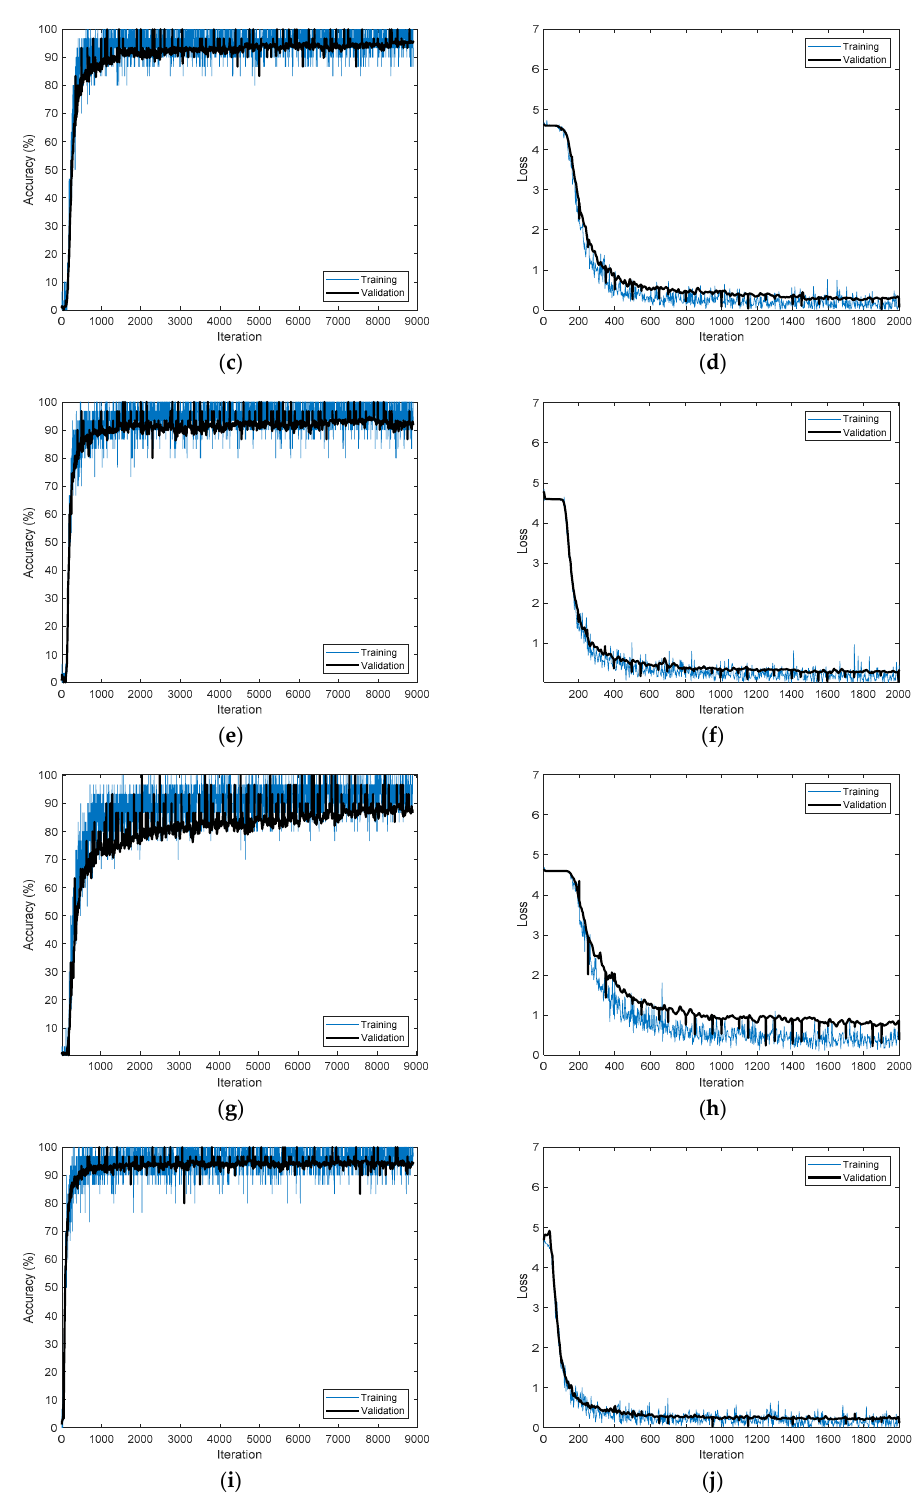
Figure 14. Training processes that achieved the best accuracies for the time-frequency representations applied to CU-ECG. ( a ) Accuracy of DenseNet-201 using MFCC; ( b ) loss of DenseNet-201 using MFCC; ( c ) accuracy of Xception using spectrogram; ( d ) loss of Xception using spectrogram; ( e ) accuracy of Xception using log spectrogram; ( f ) loss of Xception using log spectrogram; ( g ) accuracy of using Xception mel spectrogram; ( h ) loss of Xception using mel spectrogram; ( i ) accuracy of Xception using scalogram; ( j ) loss of Xception using